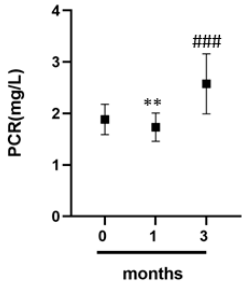
Figure 5. C-reactive protein level. C-reactive protein (CRP) dosage in professional athletes at different times 0, 1 and 3 months by a group of professional basketball athletes. Data expressed as the mean ± SD. Significance was determined by the t -test student: 0 months versus 3 months ** ( p = 0.0014) and 1 months versus 3 months ### ( p = 0.0002).